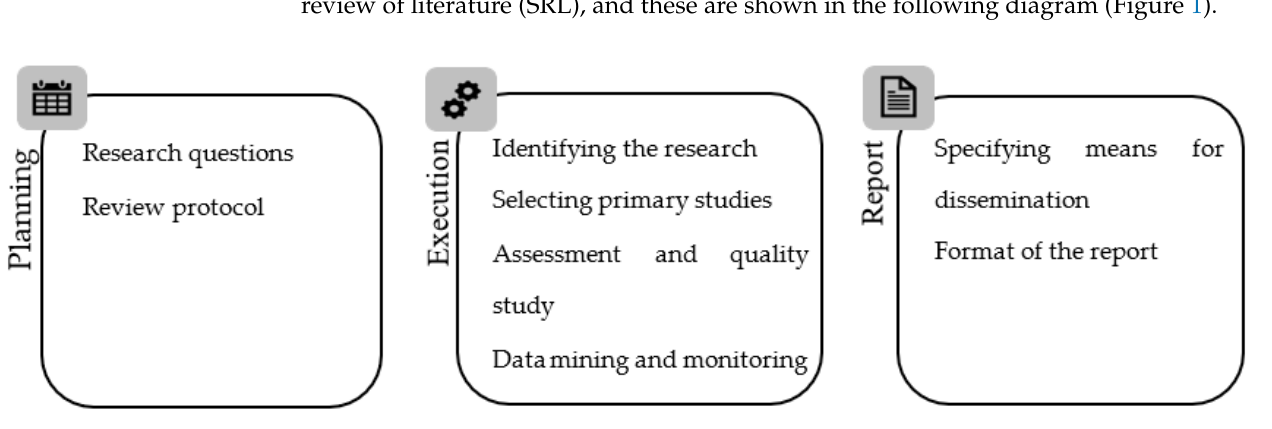
Figure 1. Phases of systematic review of literature.